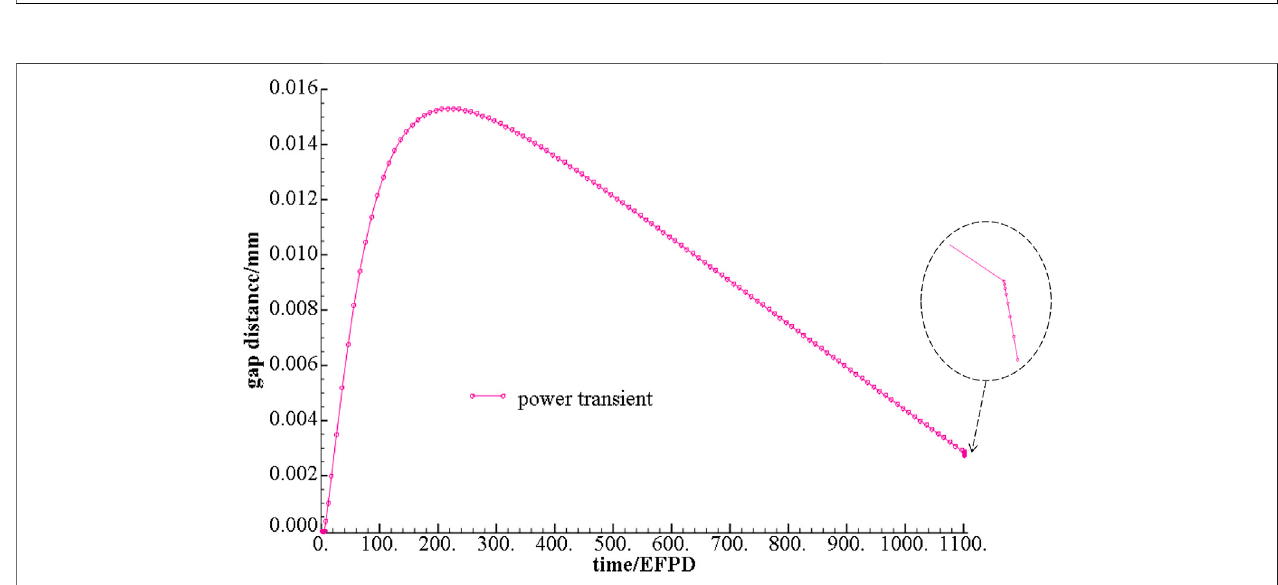
FIGURE 8 | Buffer outer diameter and IPyC layer inner diameter variation with EFPD.